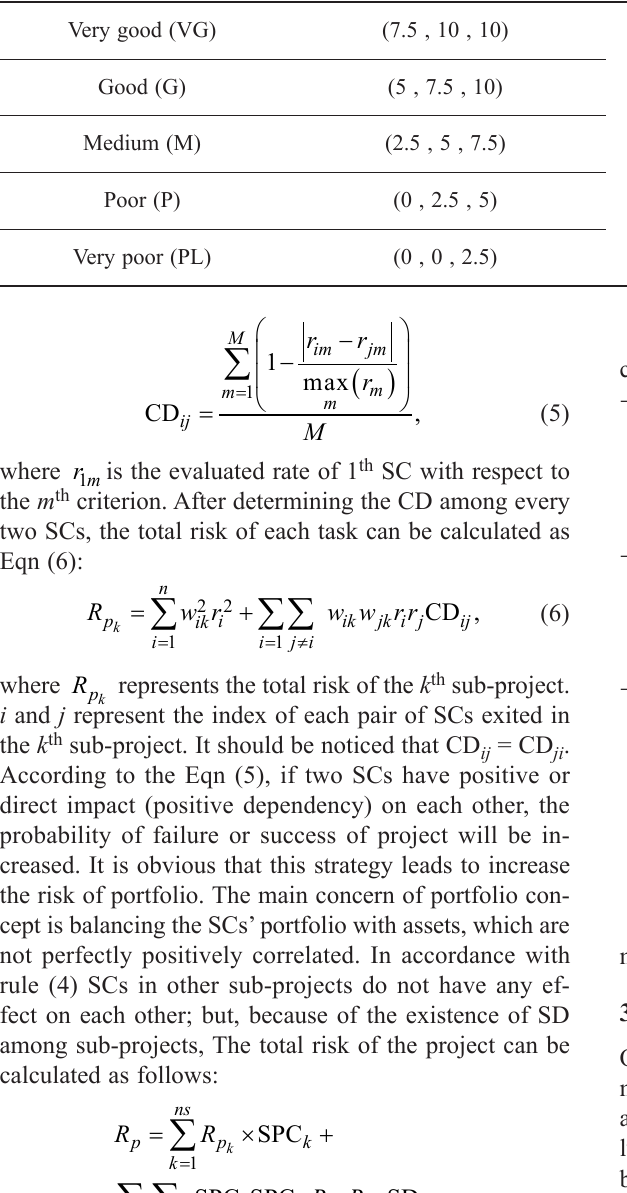
Table 1. Linguistic terms and their fuzzy members Linguistic terms Triangular fuzzy number Triangular fuzzy